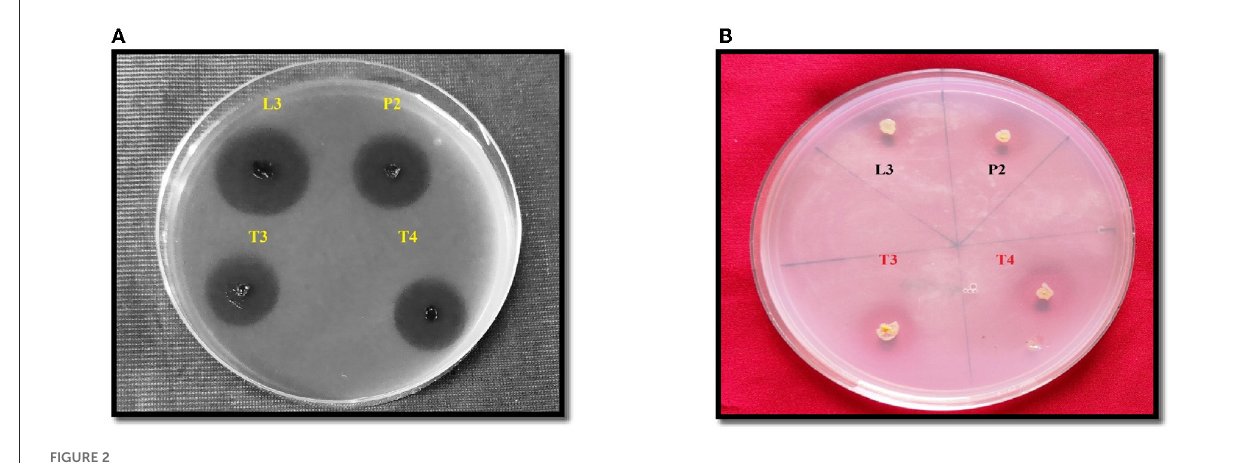
FIGURE2 PSI (A) and ZSI (B) of L3, P2, T3 and T4 PSB, forming a clear halozone around the bacterial